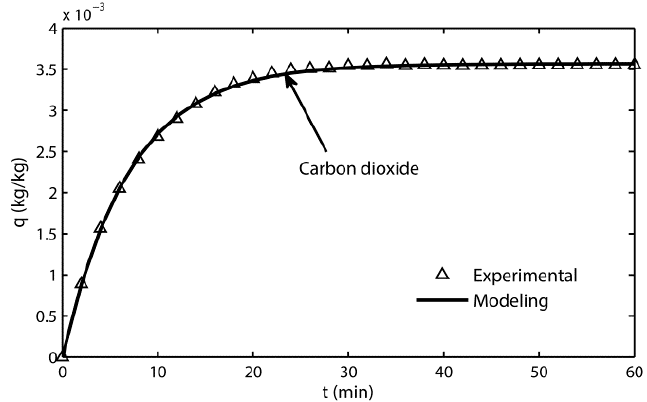
Figure 3. Experimental and modeling adsorption curves for carbon dioxide.